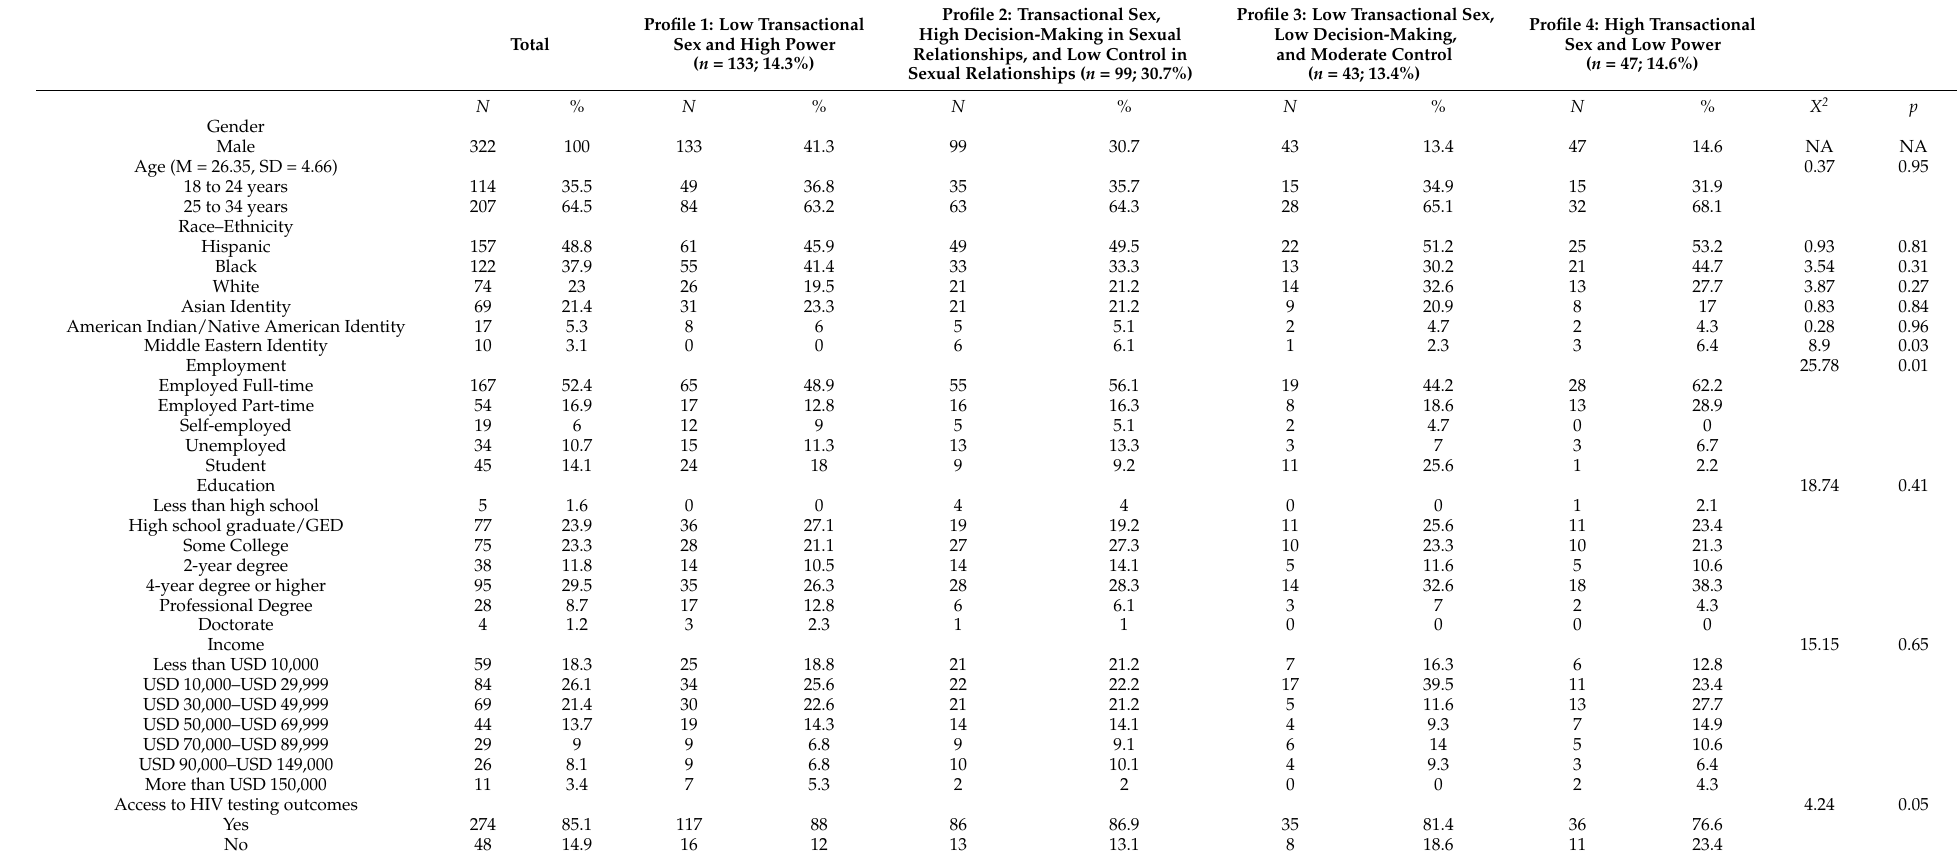
Table 1. Sociodemographic characteristics between latent profile groups ( N =